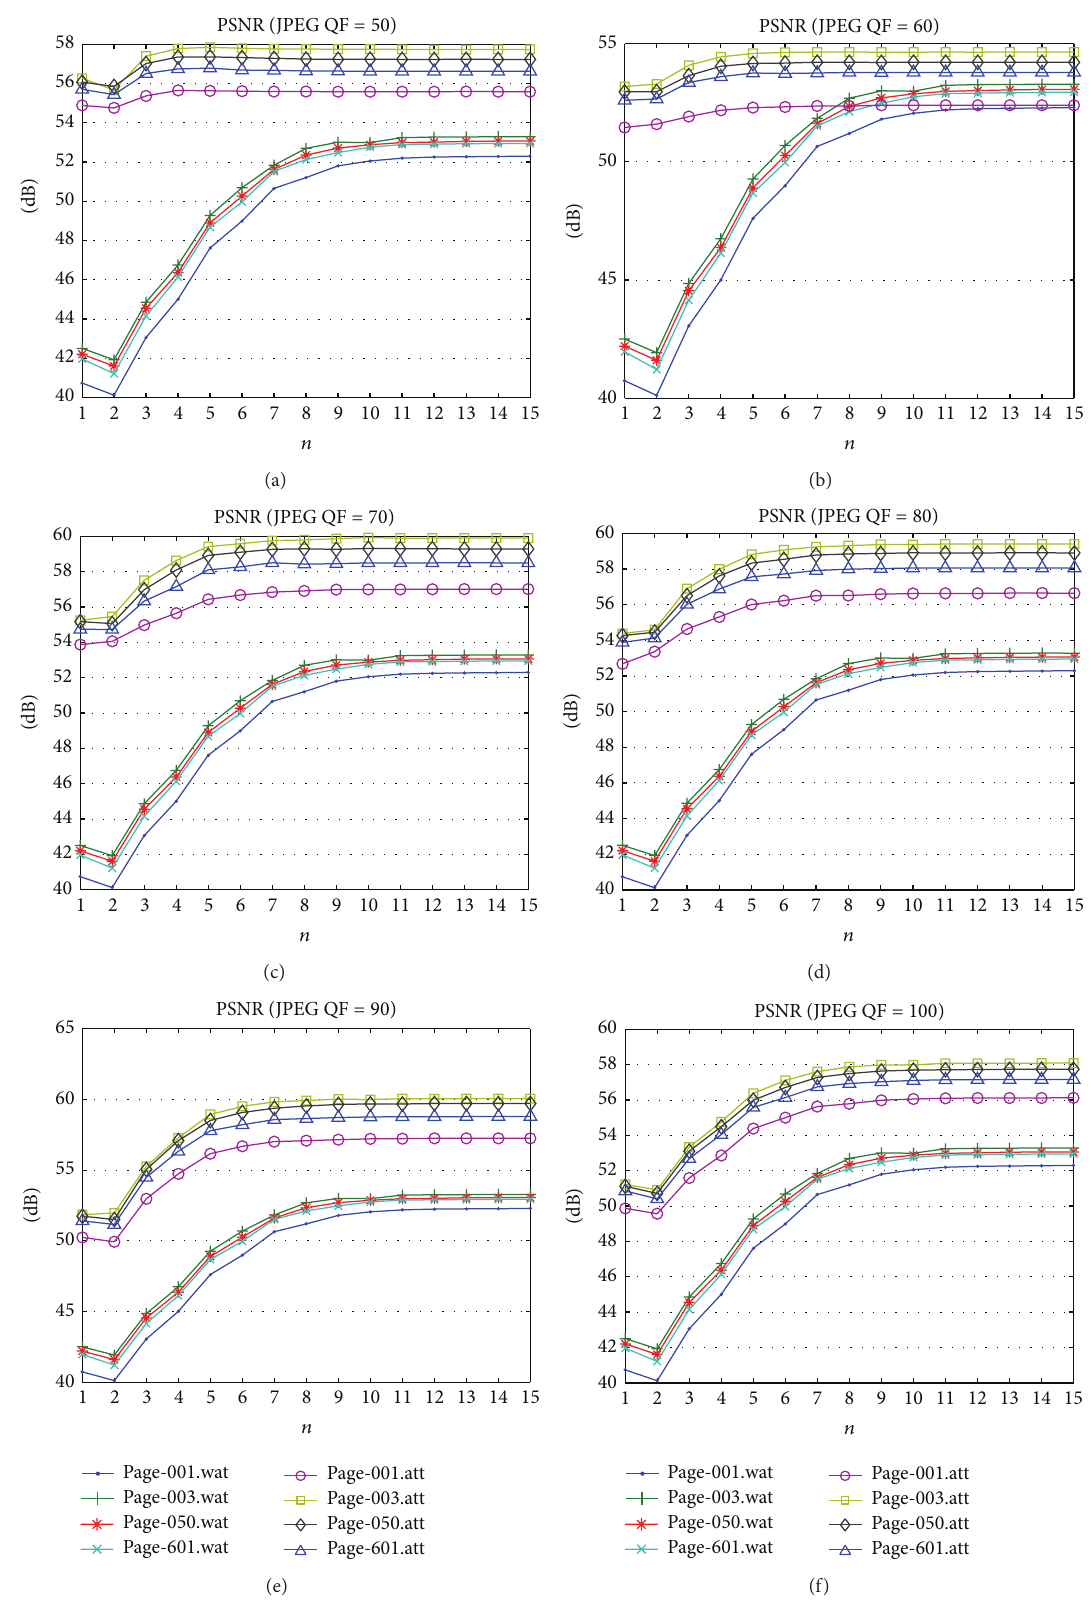
Figure 17: PSNR before and after JPEG compression, QF = [50,100]